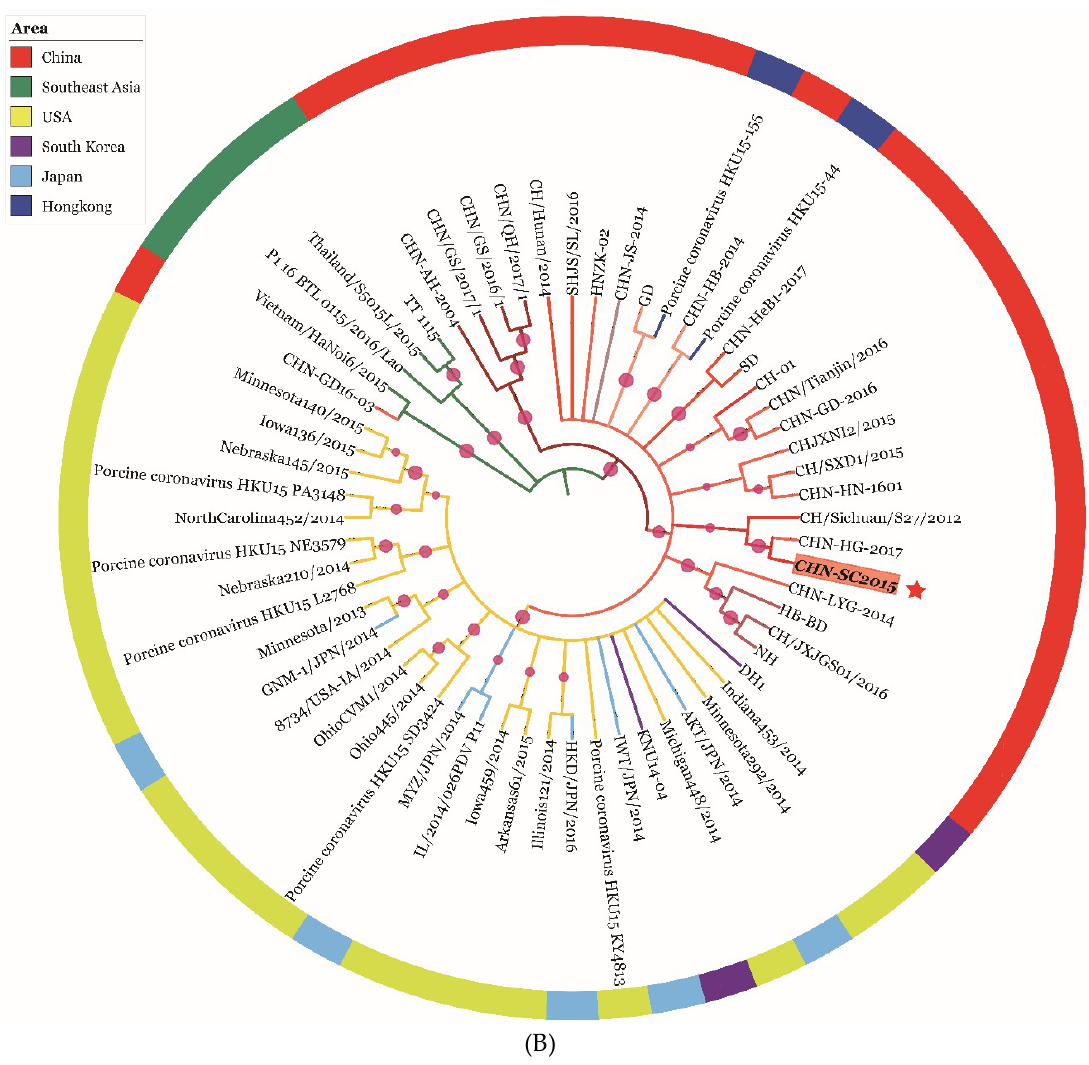
Figure 6. Phylogenetic trees based on the complete genome ( A ) and S gene ( B ) of PDCoV strain CHN-SC2015. Phylogenetic trees were constructed using the neighbor-joining method in MEGA7. CHN-SC2015 is indicated with a red asterisk. The branches in red, green, yellow, purple, light blue, and dark blue represent the clades from China, Southeast Asia, USA, South Korea, and Hong Kong, respectively. The trees were constructed using the ML method and a bootstrap analysis ( n = 1000) in Mega X software. Bootstrap values > 50% are shown at the branch points.